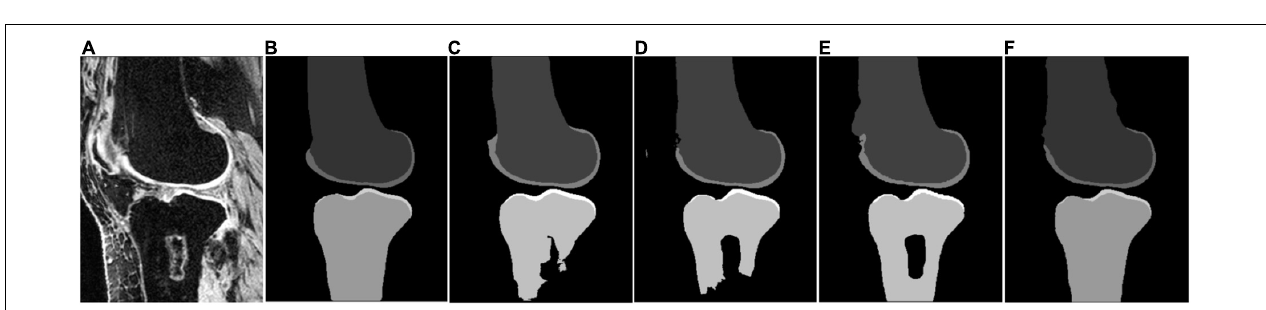
FIGURE 5 | Segmentation results based on different schemes: (A) sagittal slice of the image; (B) ground truth; (C) nnU-Net 2D; (D) nnU-Net 3D full; (E) nnU-Net 3D low; and (F) proposed